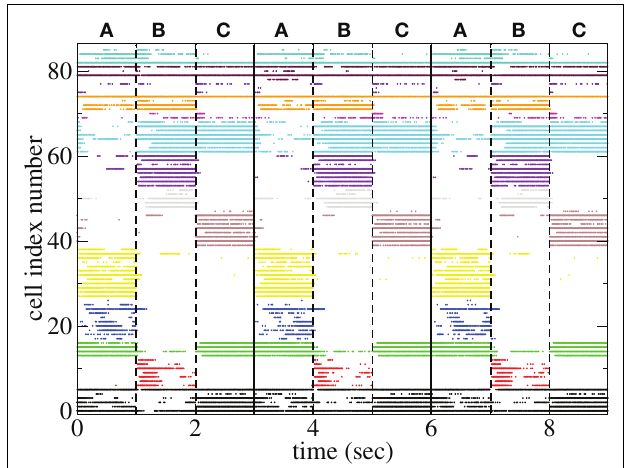
FIGURE 14 | Spike raster plot clustered by k-means algorithm with 15 clusters for 100 cell network simulations under input switching protocol 3 × 1s stimuli with high connectivity ρ = 0.6, b C = 0.001, r C = 0.0085, and α = 1.5.